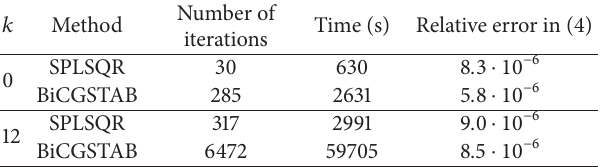
Table 1: A comparison between the SPLSQR algorithm and the BiCGSTAB iterative method for the solution of update system (4) in case of the UWCEM breast phantom. The number of iterations, the solution time, and the resulting accuracy are given for the first (𝑘 = 0) and the last (𝑘 = 12) iterations in the reconstruction